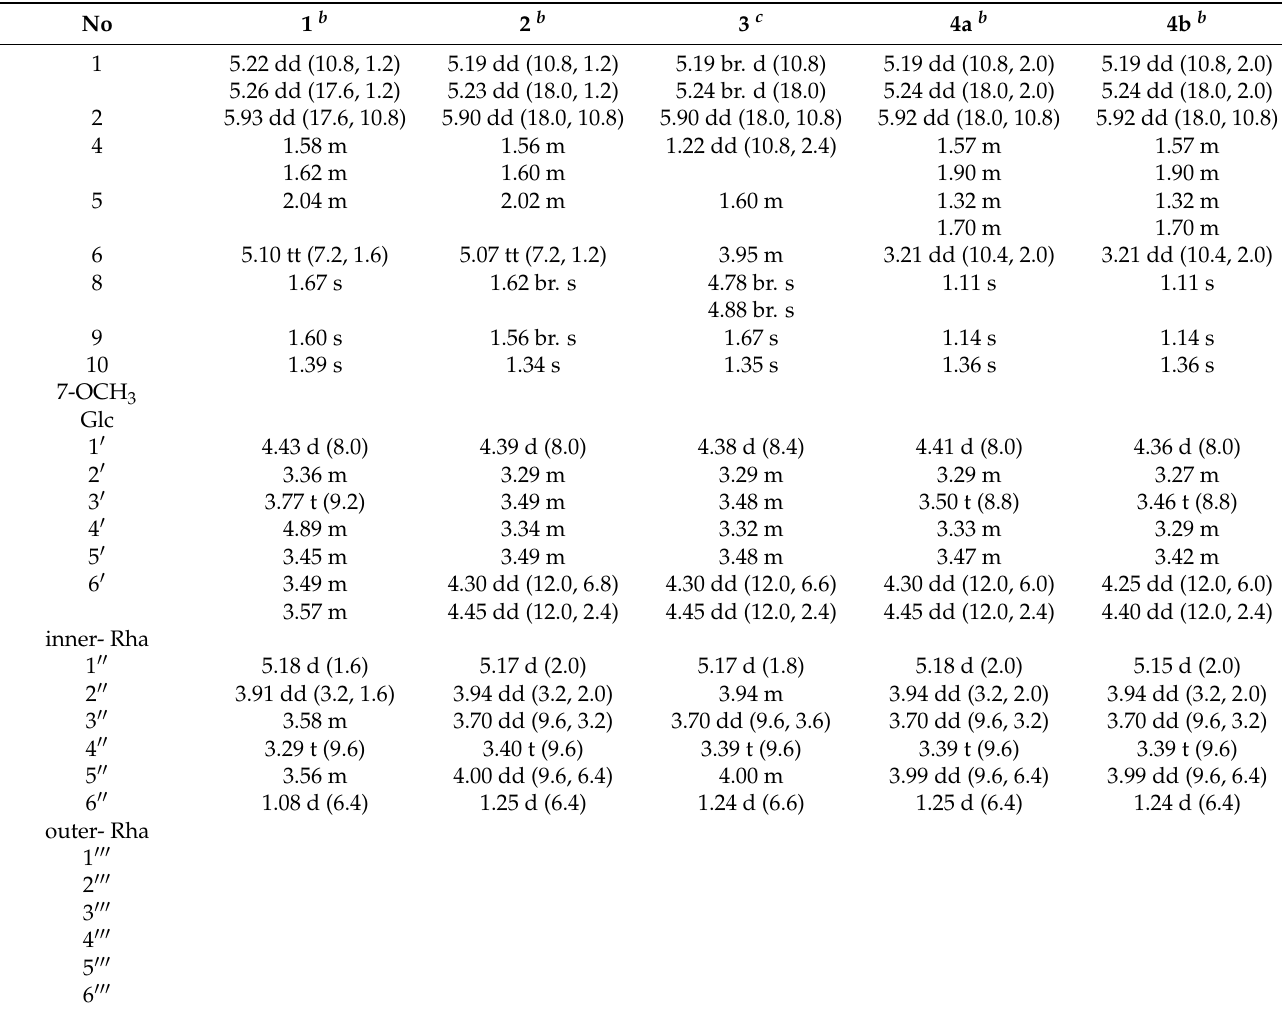
for C 31 H 44 NaO 13 , 647.2680). Table 1. 1 H NMR data of compounds 1 – 8 from L. robustum in CD 3 OD a